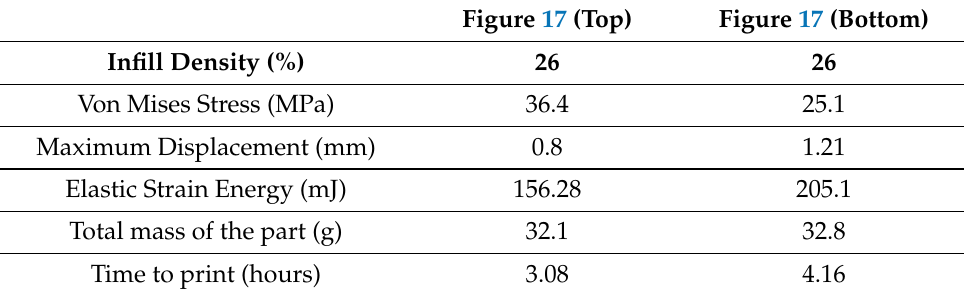
Figure 18. Printed parts with infill density of 26% having optimised infill design ( top ) and uniform infill design ( bottom ). Table 7. Comparison of the part with uniform infill to the part with infill defined by the refine- ment process using threshold stress = 17.5 MPa and minimum length of a side of the infill design (L) ≥ 2.4 mm as stopping